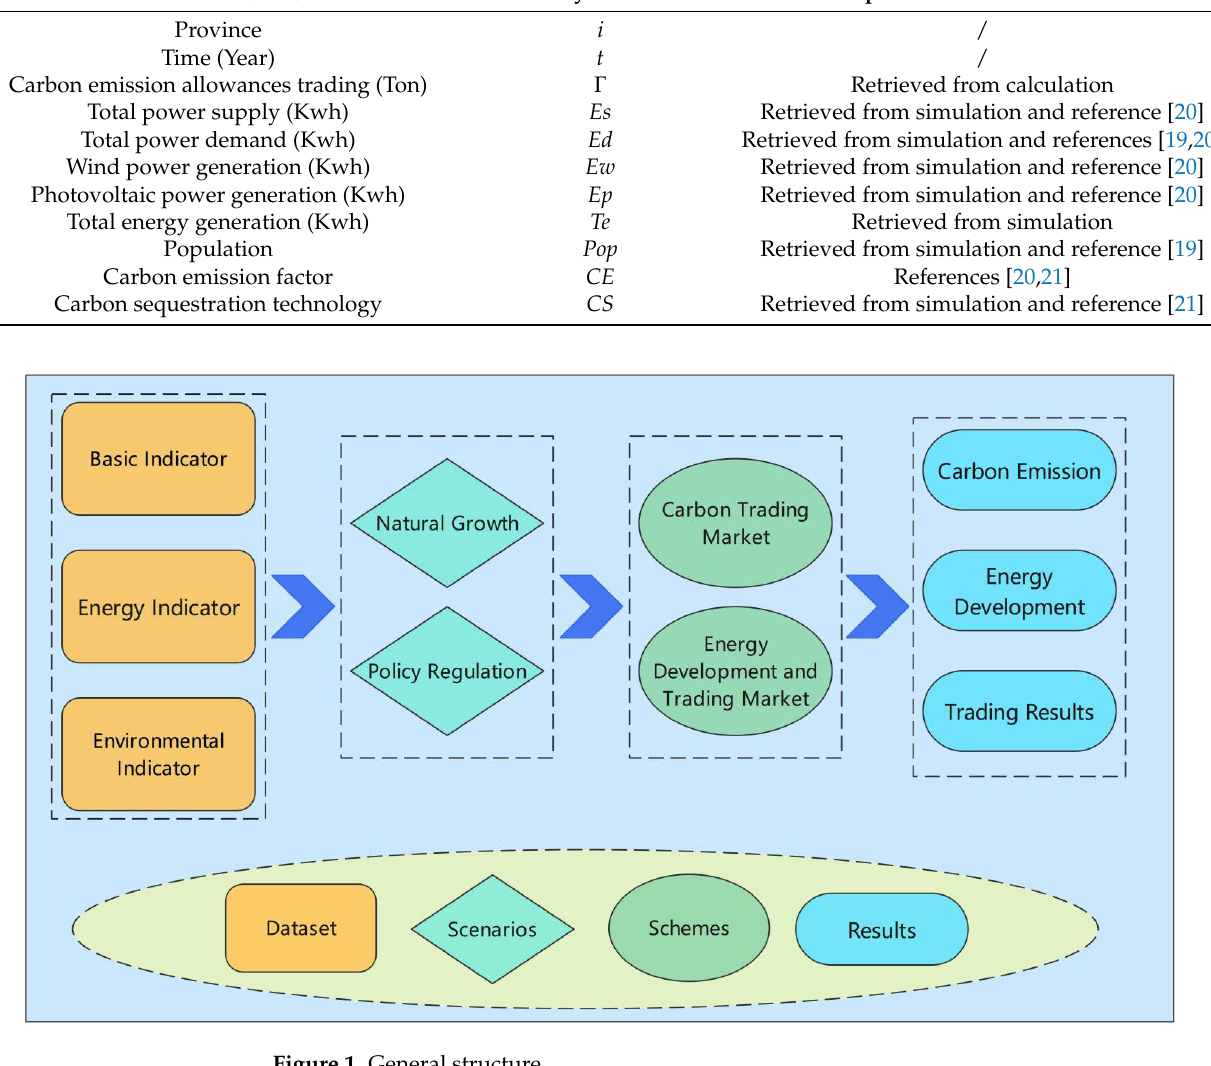
Figure 1. General structure.